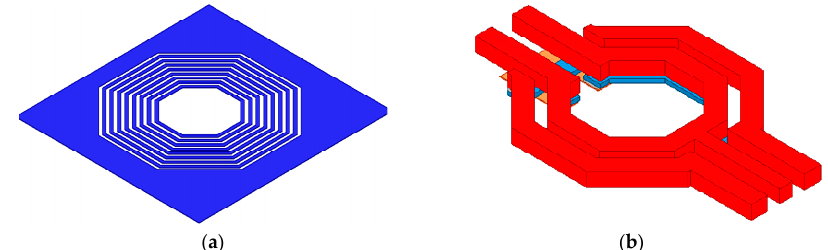
Figure 4. Pattern ground shield (PGS) used in the proposed DLNCSS inductor ( a ) and the switch inductor loaded transformer without PGS ( b ). inductor loaded transformer without PGS ( b